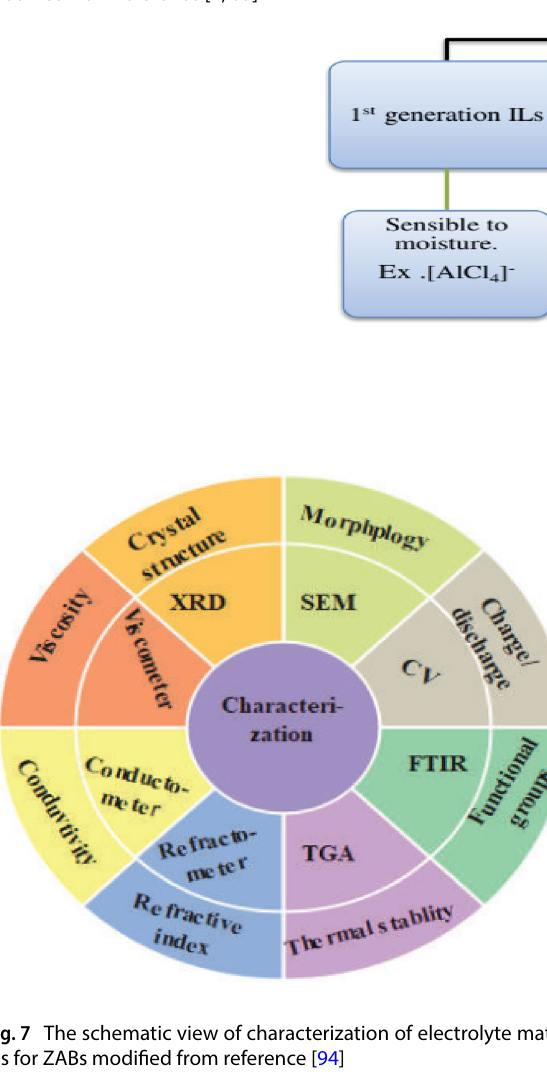
Fig. 6 Summary of the clas- sification room temperature